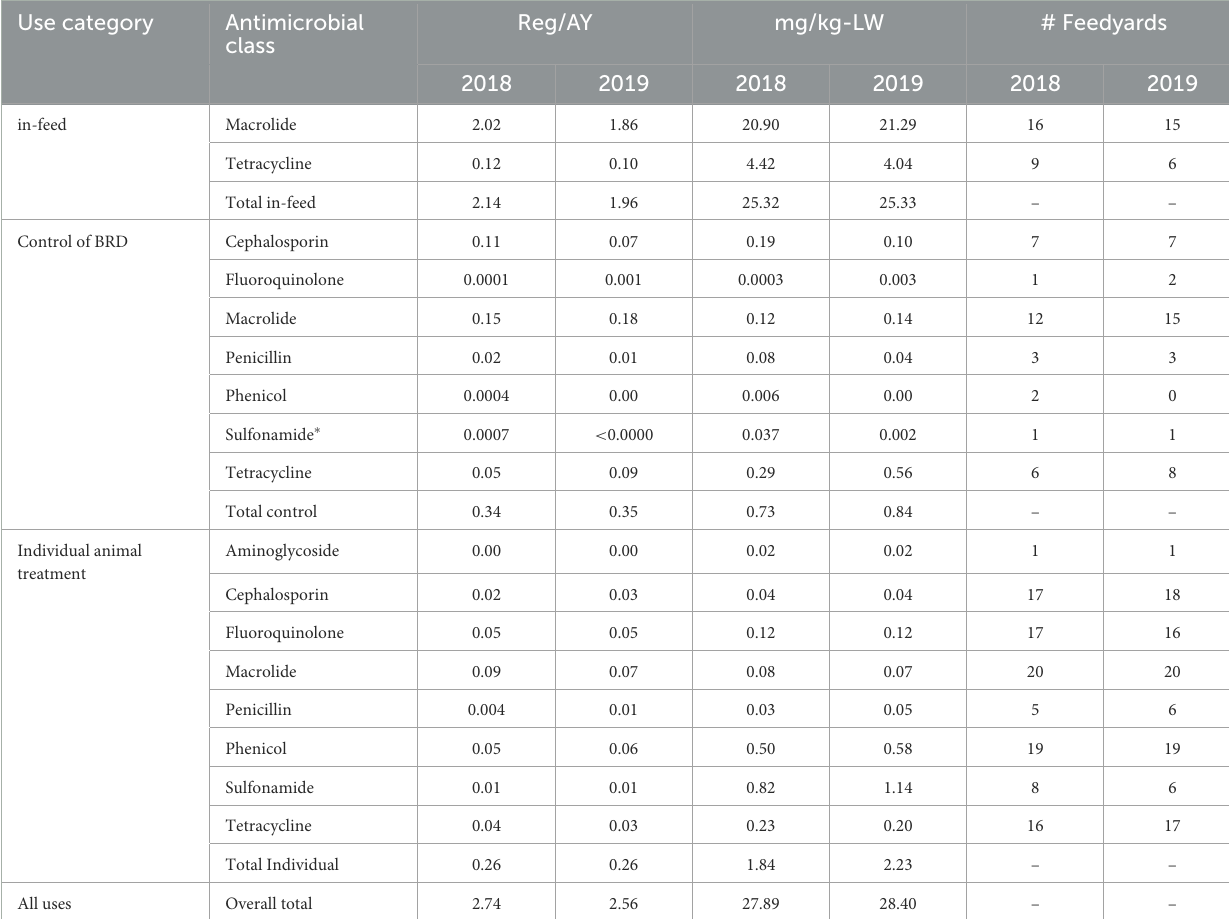
TABLE 5 Medically important Reg/AY and mg/kg-LW by antimicrobial class at the study level with feedyard count, expressed as